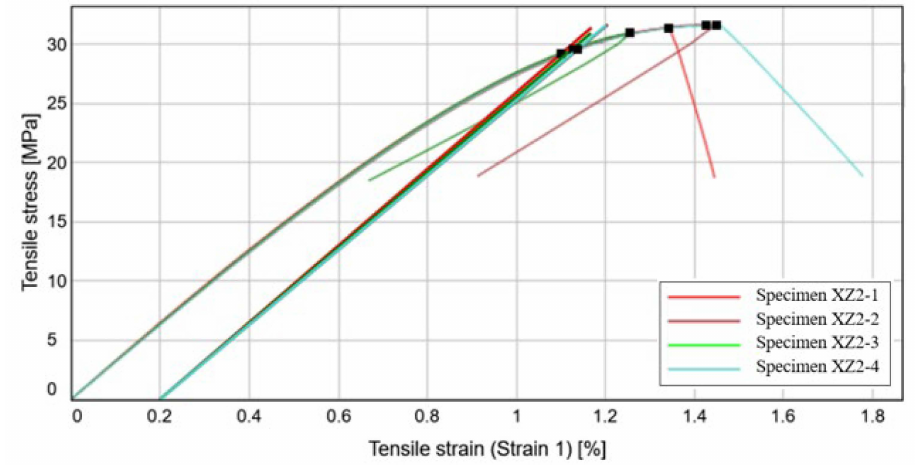
Figure 15. Stress-Strain curve variation for the XZ2 specimens. Table 5. Mechanical characteristics obtained for the XZ2